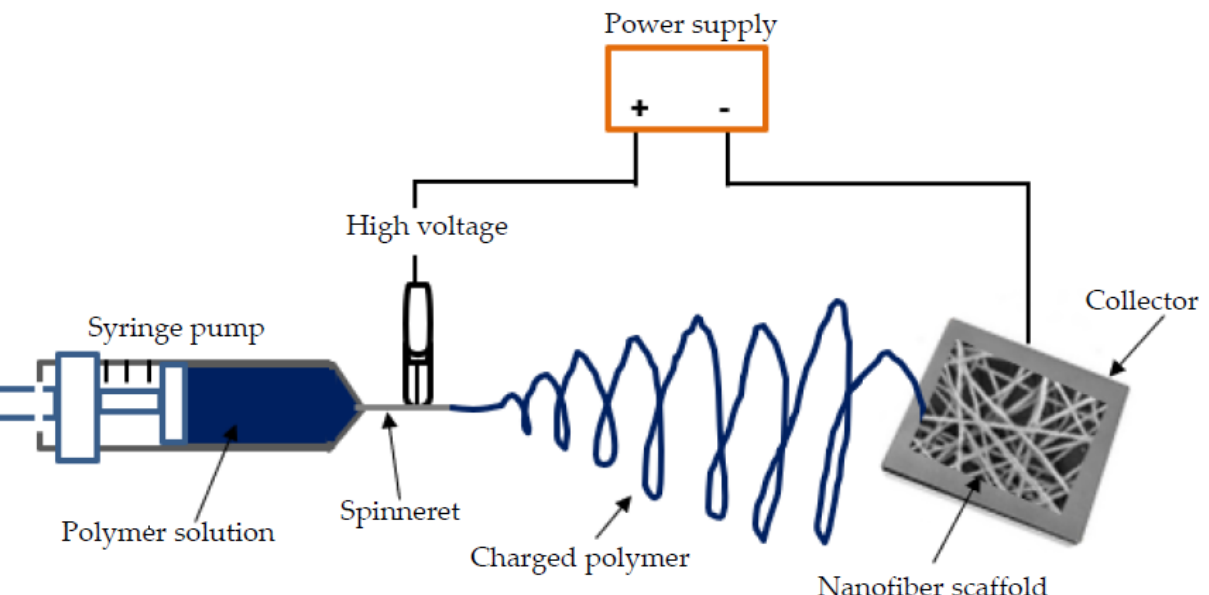
Figure 2. Schematic representation of a basic electrospinning horizontal set ‐ up.